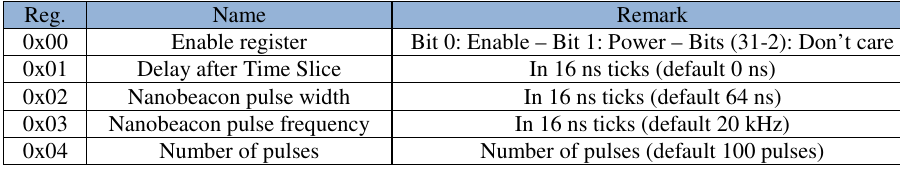
Figure 1 . The Nanobeacon pulser board for the KM3NeT